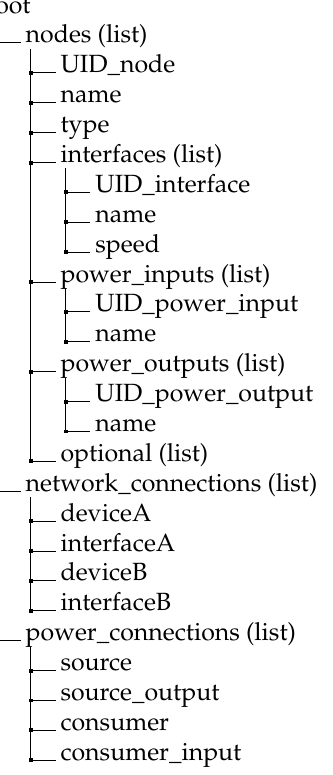
Figure 4. JSON file tree